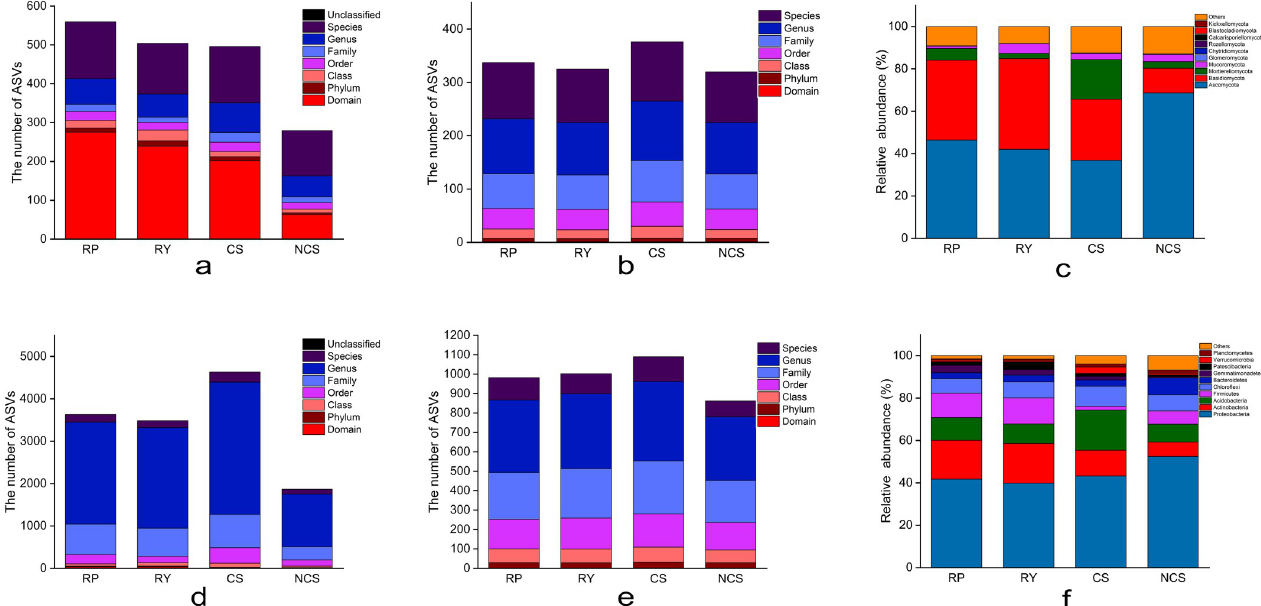
Fig 1. Annotation analysis of microbial composition in different soil and rhizosphere samples. (a, b, c) and (d, e, f) are the annotation analysis results of fungal and bacterial taxa respectively. (a, d) The number of ASVs in each sample that can be annotated to domains, phyla, classes, orders, families, genera and species. (b, e) The number of taxa contained in different samples at each classification level obtained from the flattened statistical data. (c, f) The abundance of the top 10 taxa at the phylum level. All data shown in the figure are averaged within the group.